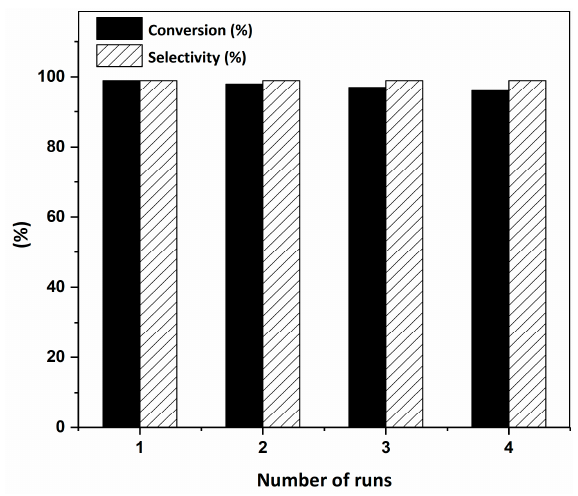
Figure 4. Recyclability of the Ru III @bipy-CTF catalyst (1 mol% catalyst, 0.33 mmol benzyl alcohol, 0.4 mmol Cs 2 CO 3 , 500 μ L toluene, 0.33 mmol malononitrile, O 2 , 100 °C, 12 h (1st step) and 70 °C, 1 h (2nd step).